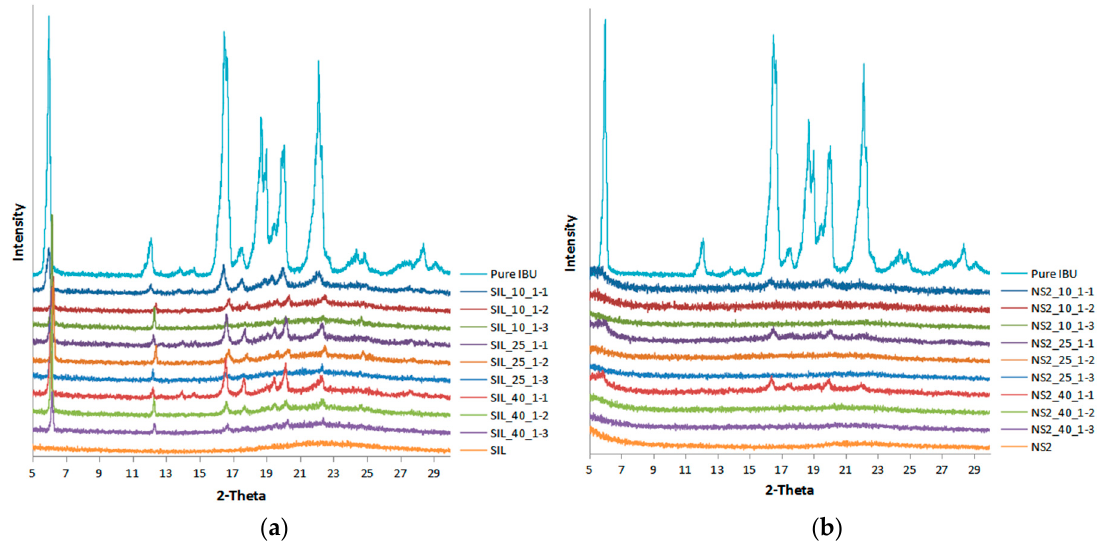
Figure 3. X-ray powder diffraction (XRPD) results of the drug-loaded ( a ) S244FP and ( b ) NS2 under different drug loading conditions (refer to Table 1 for sample details). different drug loading conditions (refer to Table 1 for sample